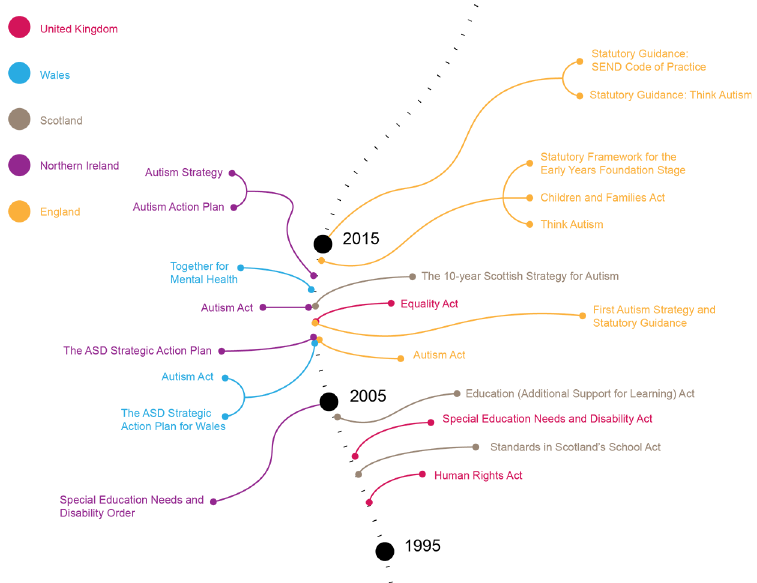
Fig 3. An overview of the SEN and autism policies in the UK and its constituent